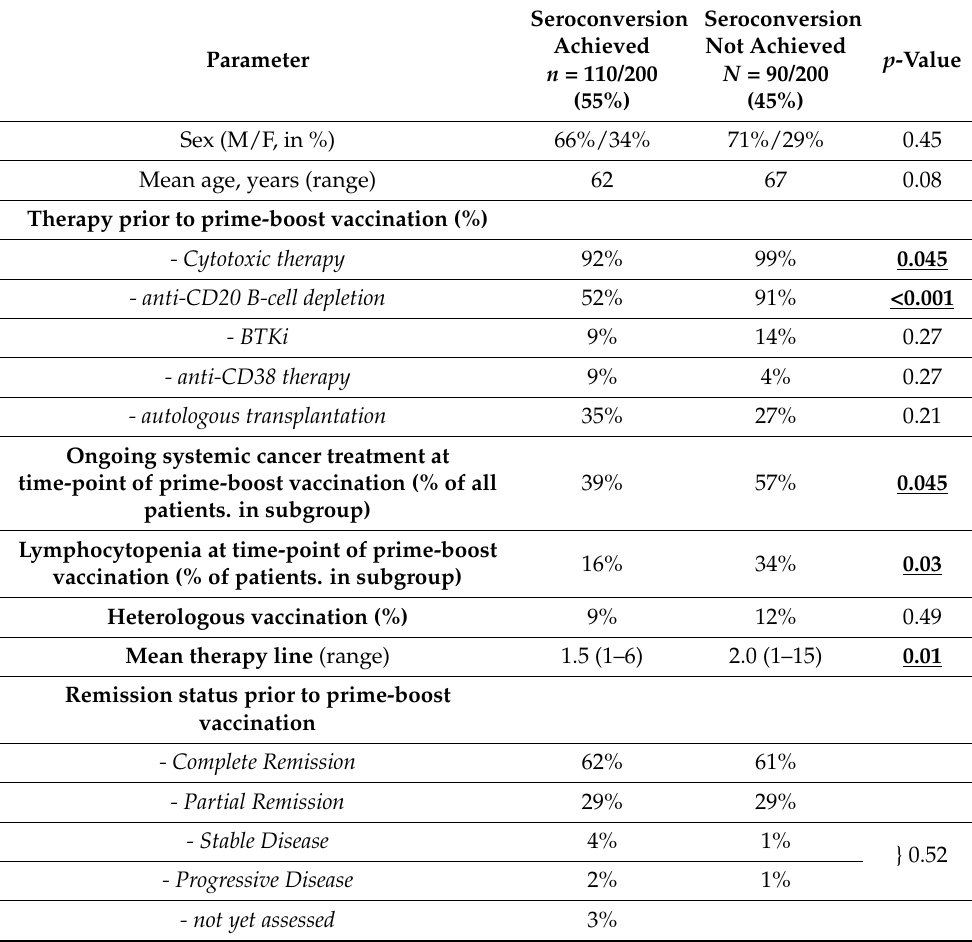
Table 2. Incidence of serologic response and non-response to prime-boost vaccination according to patients’ characteristics and treatment modalities.